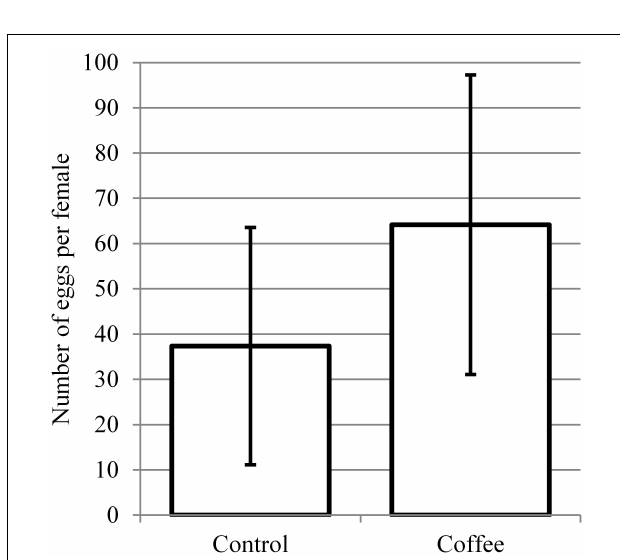
FIGURE 4 | Oviposition by females reared in water ( N = 12) or 15% coffee ( N = 13). Means are significantly different by t -test ( p = 0.0356).